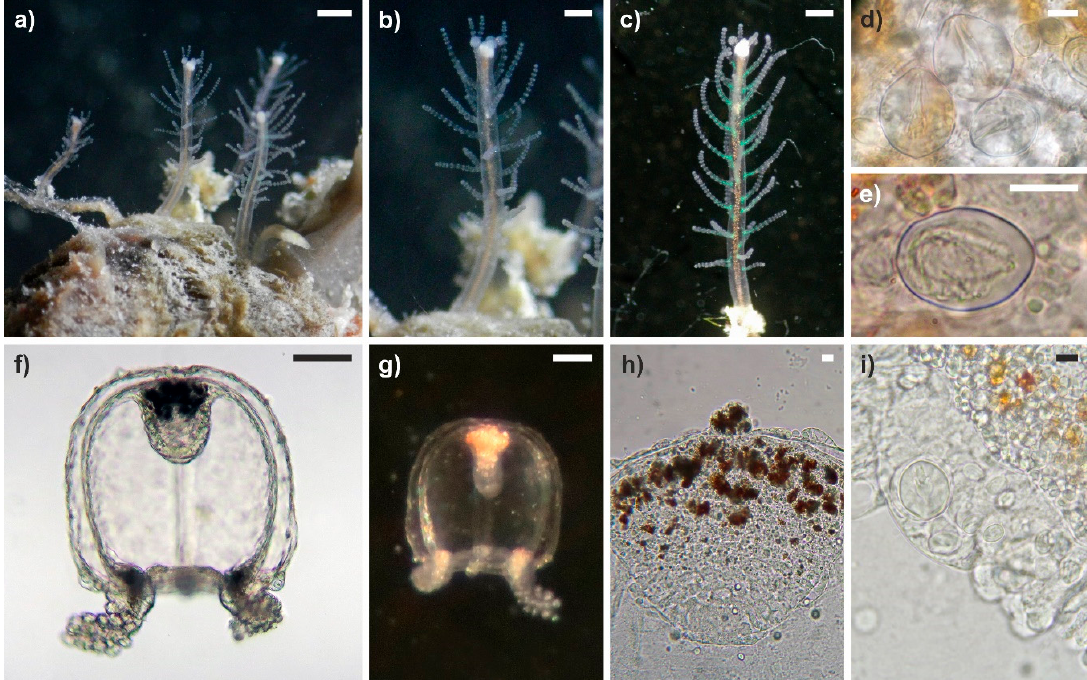
Figure 7. Asyncoryne ryniensis . ( a ) Colony growing on dead coral; ( b ) close-up of a polyp; ( c ) polyp showing green fluorescence before stimulation with blue light; ( d ) stenoteles in the capitulum, and ( e ) eurytele in the hydranth; ( f,g ) newly released medusa; close-ups of ( h ) manubrium, and ( i ) nematocysts in the tentacular bulb. Scale bars: ( a ) 0.1 mm; ( b,c,f,g ) 0.1 mm; ( d,e,h,i ) 10 μ m.